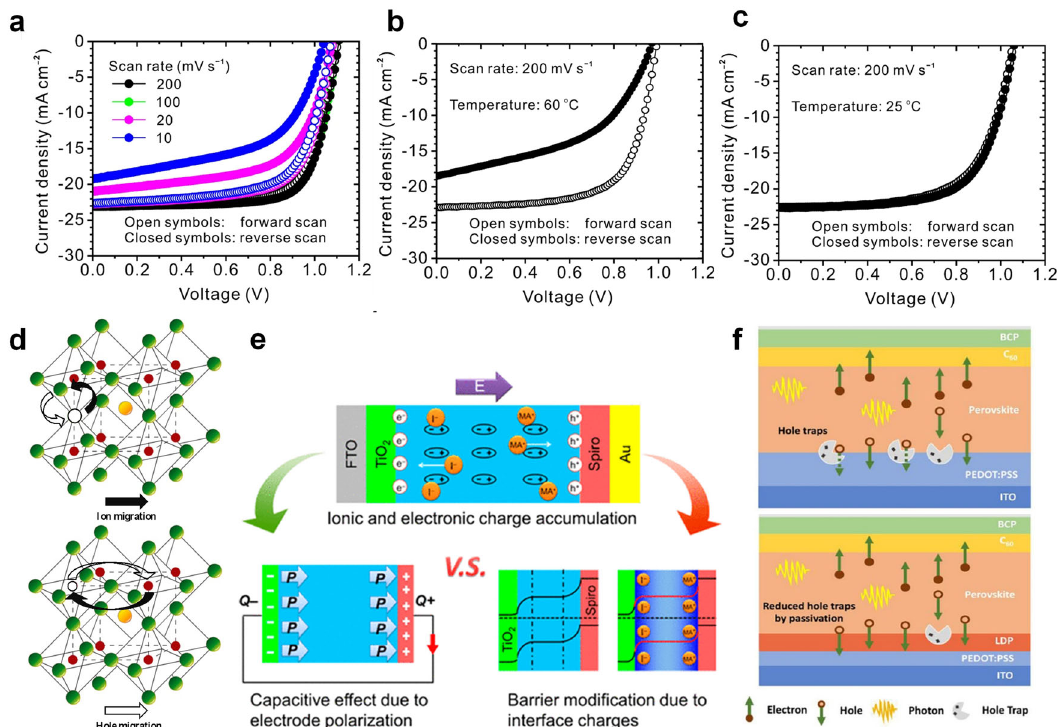
Fig. 7 In fl uence of the intrinsic factors on the photovoltaic parameters of Sn-HPSCs. a Scan-rate-dependent J – V curves of PSCs. Effect of temperature on the hysteresis of PSCs at a fast scan rate of 200 mV/s; J – V curves measured b at 60 °C and c after cooling to room temperature. Schematic illustrations of d ion and hole migration due to iodide vacancies (top) and metal vacancies (bottom) through the perovskite structure, e the in fl uence of modifying electrode polarisation on capacitive effect, the impact of contact barrier modi fi cation due to ionic interface charges, f the surface recombination reduction by passivating the trap states. (Fig. 7 a – c adapted with permission from ref. 109 , Copyright 2020 Springer Nature. Fig 7d adapted with permission from ref. 136 , Copyright 2015 Royal Society of Chemistry Fig. 7e adapted with permission from ref. 112 , Copyright ACS Publications. Figure 7f reproduced with permission from ref. 120 , Copyright 2021